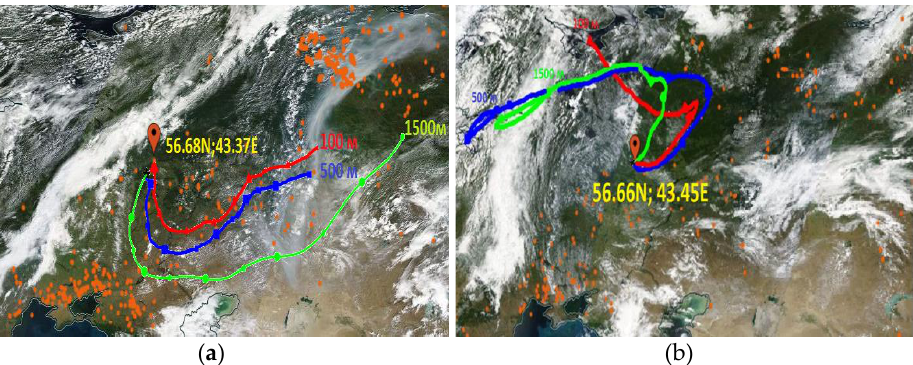
Figure 10. Results of modeling of the five-day HYSPLIT reverse trajectories for the Gorky Reser- voir for 8 August 2022 ( a ) and 27 July 2022 ( b ).